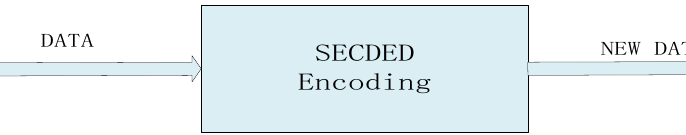
Figure 5. Data encoding module.